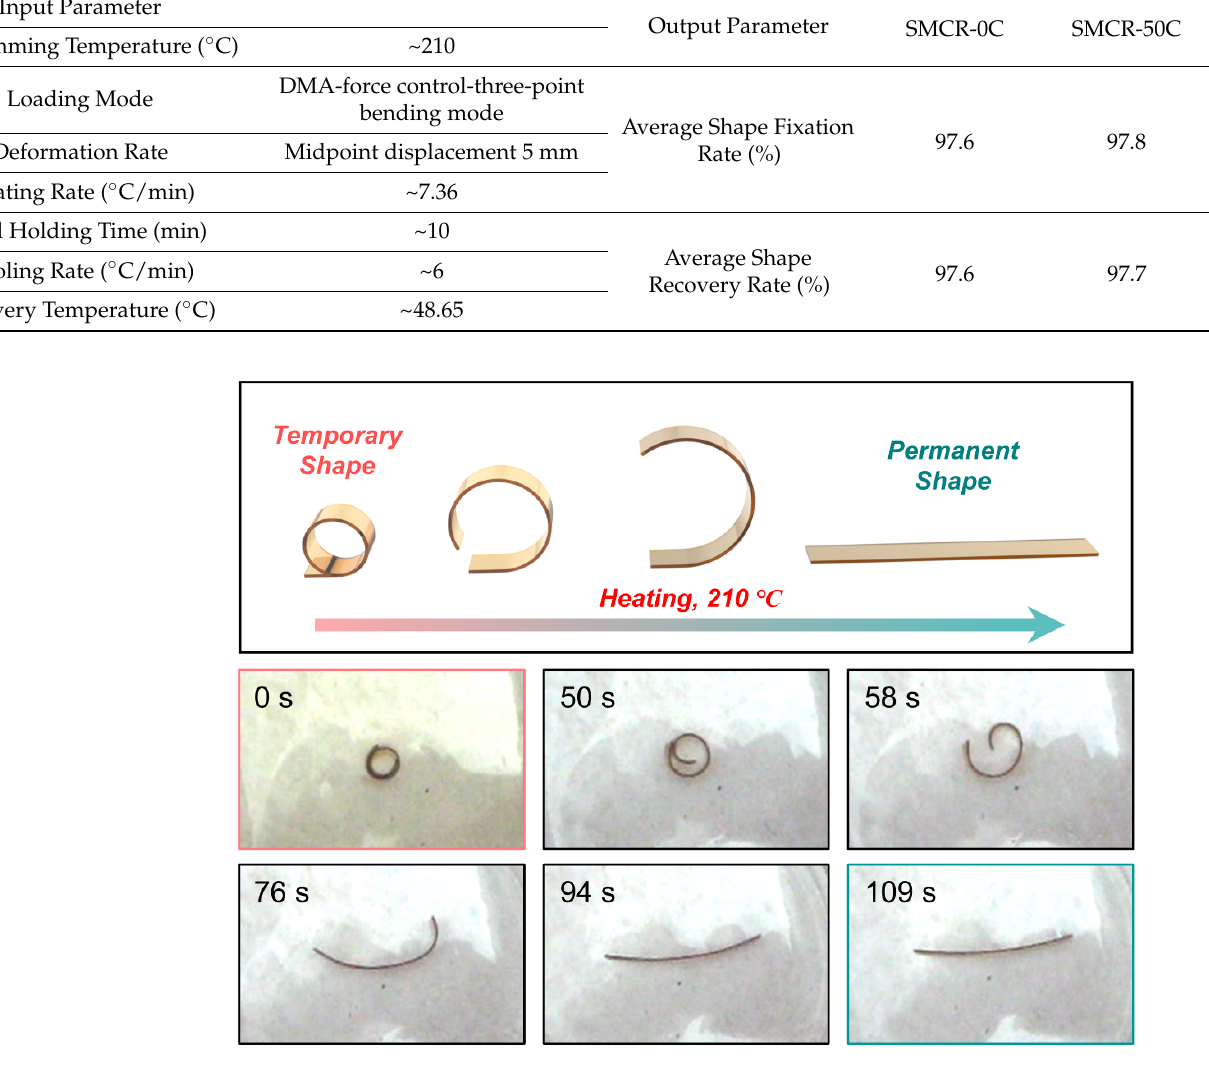
Figure 6. Shape recovery process for SMCR-50 C with toroidal temporary shape.